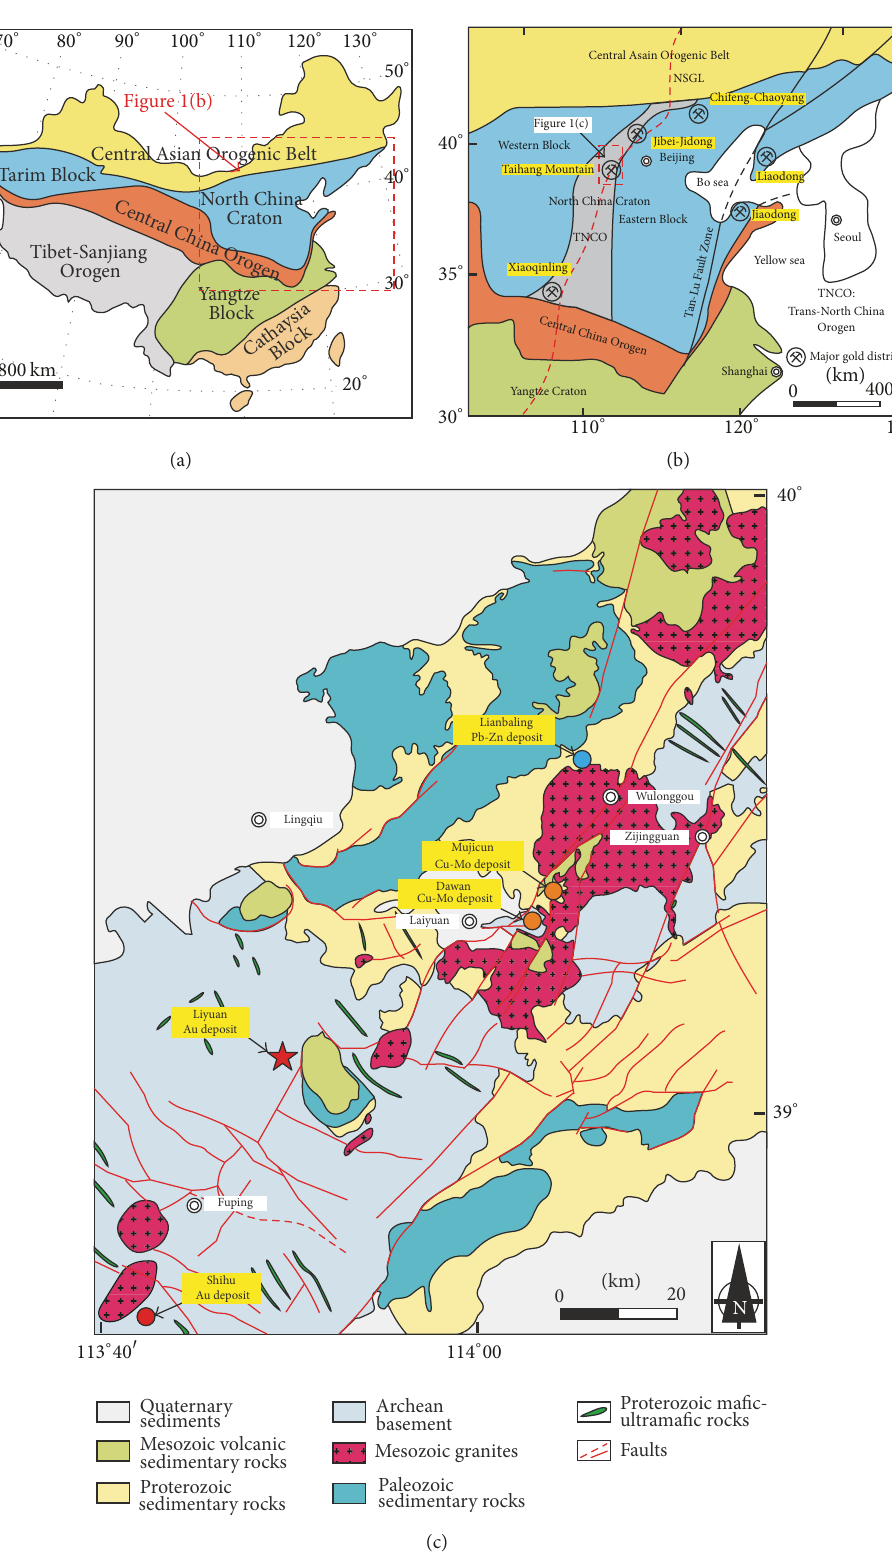
Figure 1: (a) Tectonic subdivisions of China, showing the location of the North China Craton (after [28]). (b) Tectonic settings of the North China Craton, also showing the major gold districts in the North China Craton (after [29]). (c) Regional geological map of the Liyuan gold deposit, modified after Wang et al. [21]. “Red-circle”: Au deposit, “orange-circle”: Cu-Mo deposit, and “sky blue-circle”: Pb-Zn